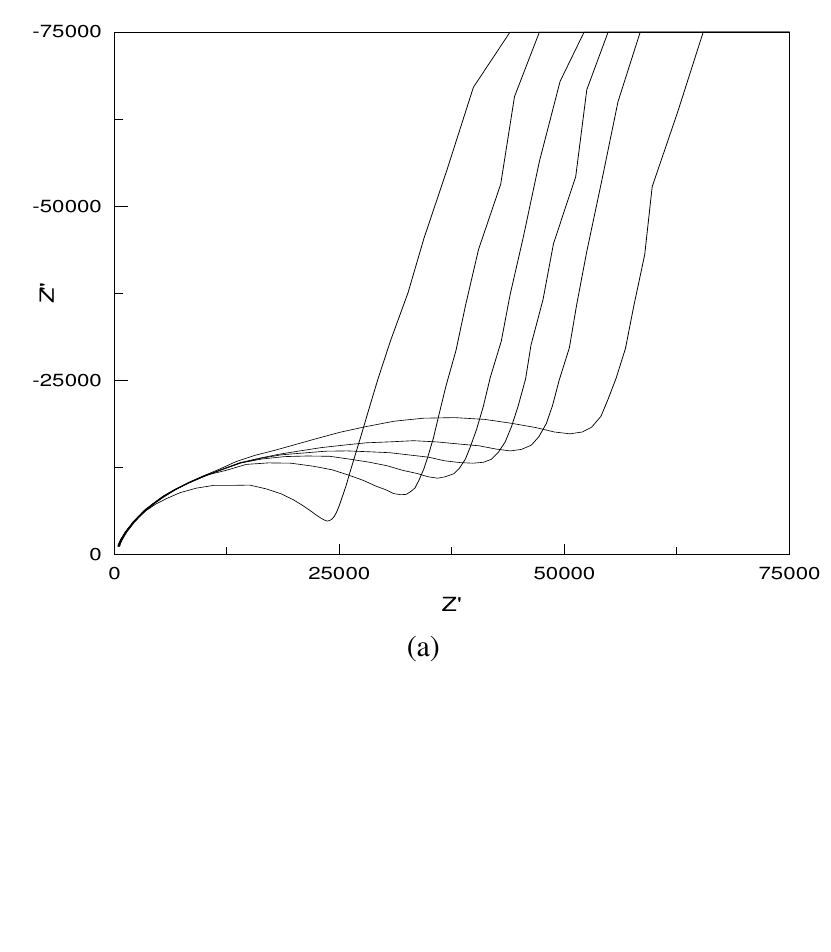
Figure 4. Typical Nyquist plots of the AC impedance measurements in NaCl solutions: (a) impedance increases with the increase in electrode distance; (b) impedance increases with the increase in particulate size; (c) impedance decreases with the increase in layer thickness; (d) impedance decreases with the increase in solution